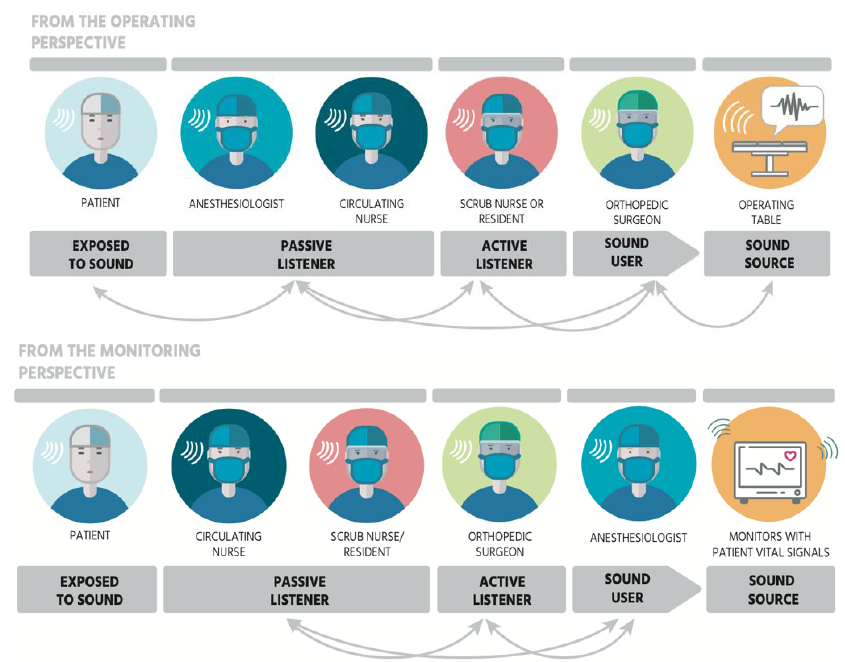
Figure 12. Listening attention fluctuates within the OR and is shown by arrows in the figures. Listeners switch attention and change roles in workflows according to the task at hand, e.g., from the operating perspective (i.e., surgeon) in the top image and from the monitoring perspective (i.e., anaesthesiologist) in the bottom image.